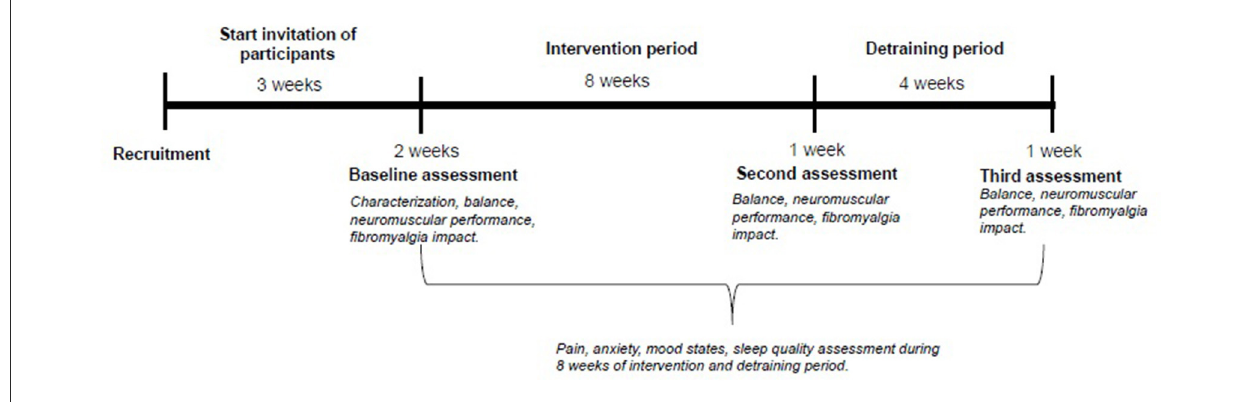
FIGURE2 Schematic diagram of steps and procedures.